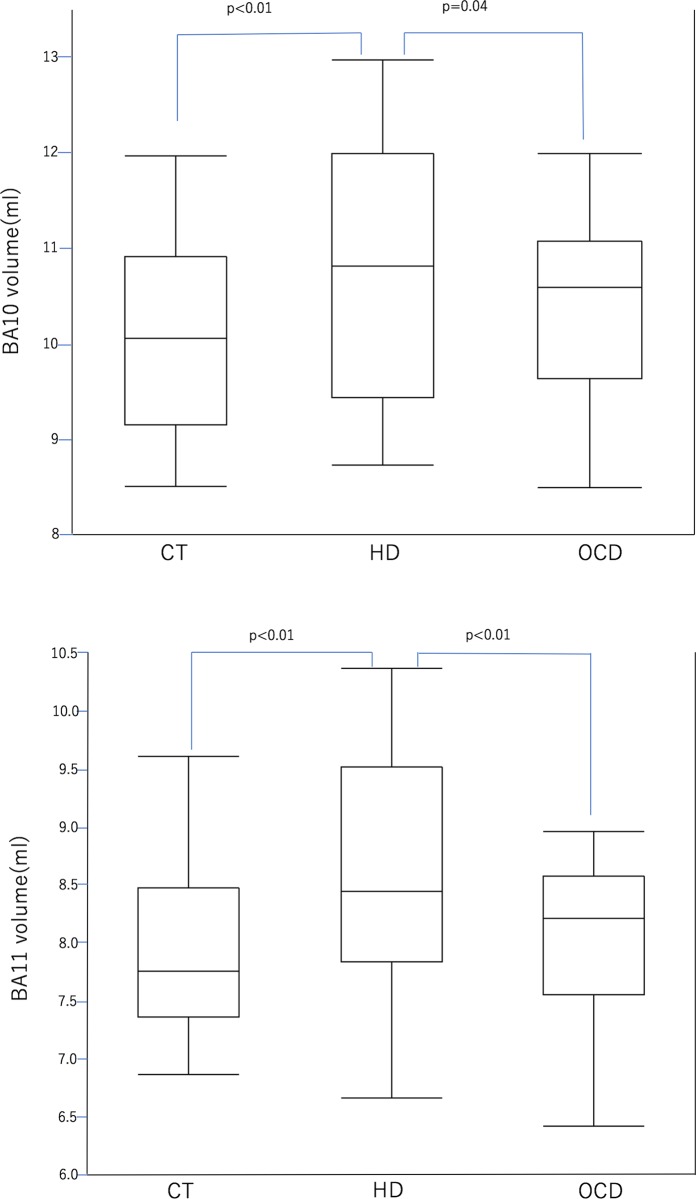
The results of ROI analysis.In the comparison of the three groups based on the gray matter volume obtained by ROI analysis, the HD group showed significantly increased GM volumes compared to the OCD group and the healthy control group (p<0.05) in both BA10 and BA11.